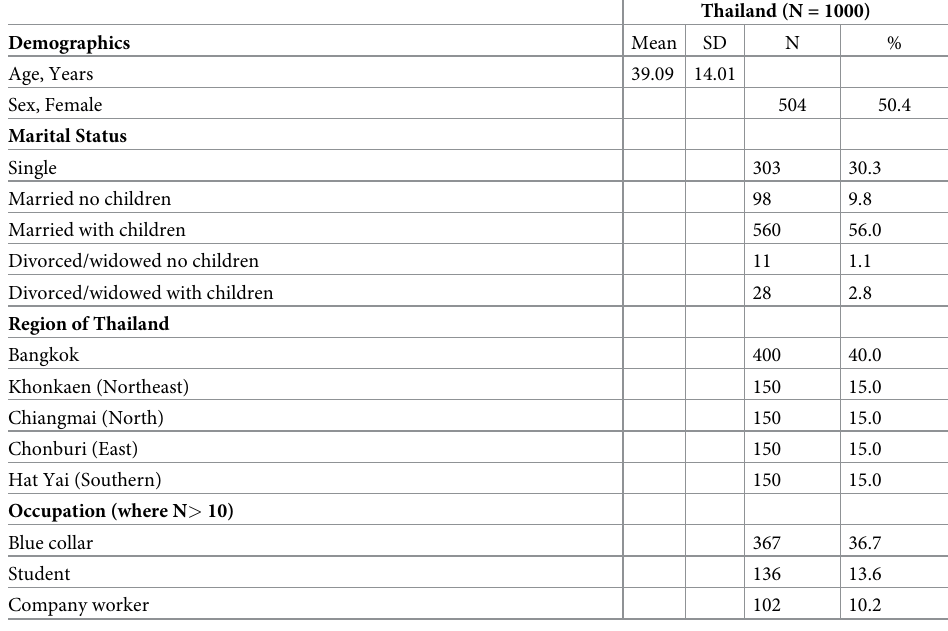
Table 1. Participant characteristics, psychological distress, values and relationship